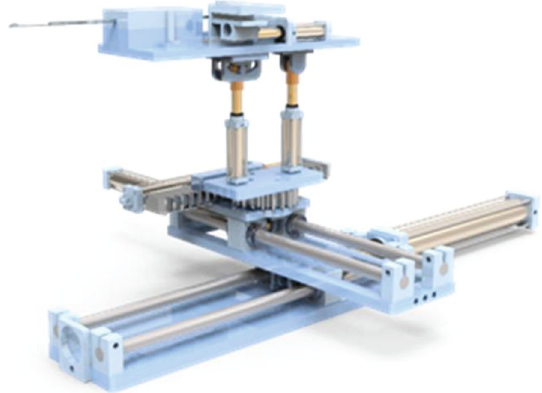
Figure 7: Hydraulic-driven MRI-compatible breast interventional robot structure.